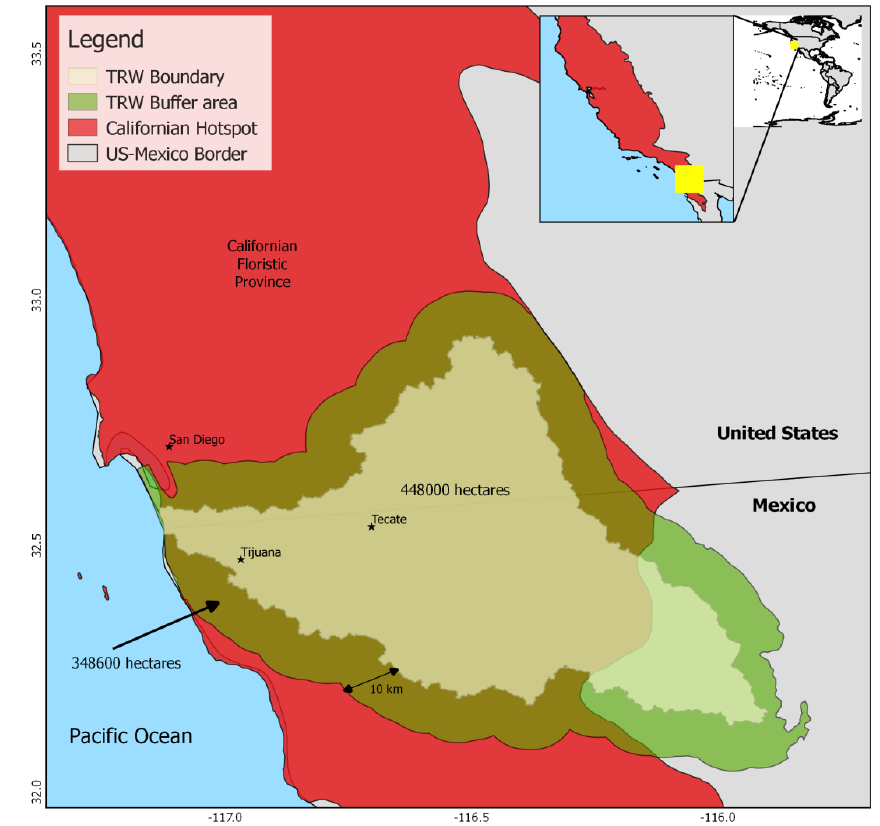
Figure 1. Binational and local settlement of Tijuana River Watershed. Source: Produced with information from http://www.cec.org/ and http://trw.sdsu.edu (accessed on 1 April